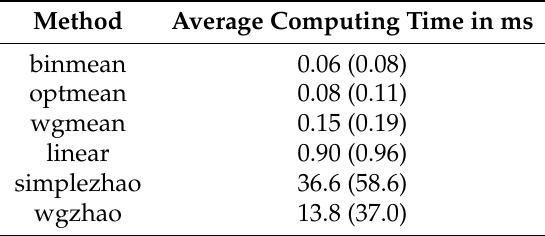
Table 2. Average computing times for a single grid point with n = 50 ( n = 200)